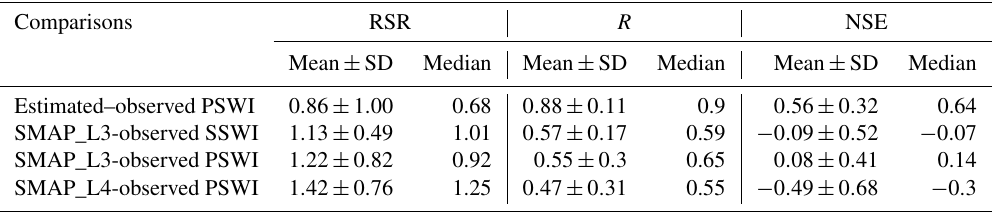
Table 6. Statistics of the metrics (RSR, R , NSE) of the comparisons of estimated–observed profile SWI datasets, SMAP_L3-observed surface SWI datasets, SMAP_L3-observed profile SWI datasets, and SMAP_L4-observed profile SWI datasets for the 35 stations during the growing seasons of 2015 and 2016.